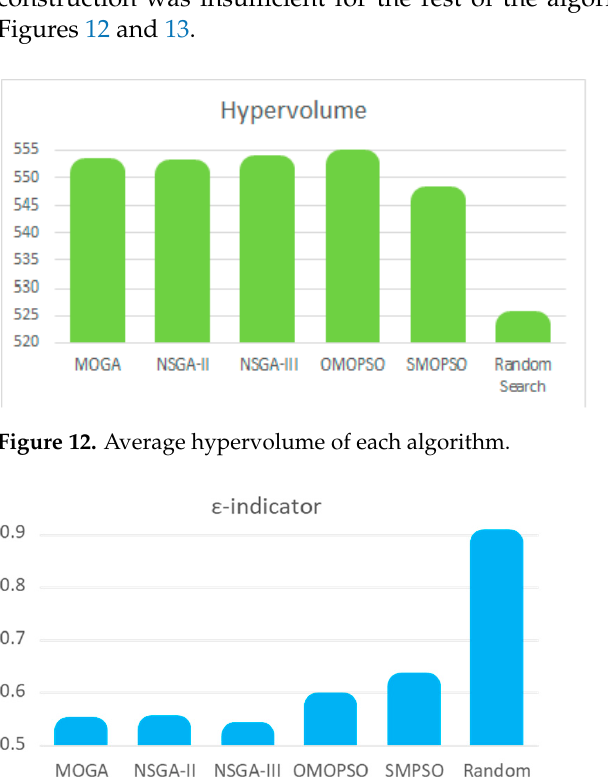
Figure 14. Plot chart mapping the studied algorithms according to the ET and the GD . This case yields the selection of either MOGA or OMOPSO algorithms as the best for optimization accuracy. Both metrics penalize SMPSO, which obtains a GD even worse than RS. Figure 15 prioritizes the HV (the inverse in this case for obtaining a homogeneous visualization) with the ET.